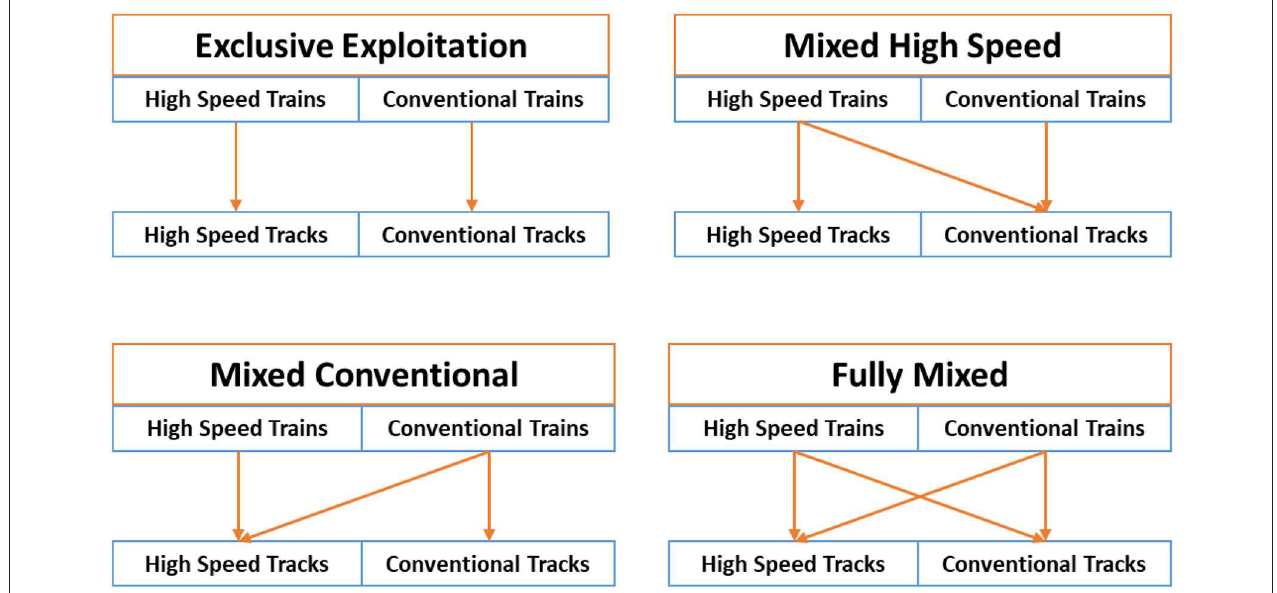
FIGURE 1 | High-speed degrees of separation. Source: (Rutzen and Walton, 2011; De Rus, 2012).